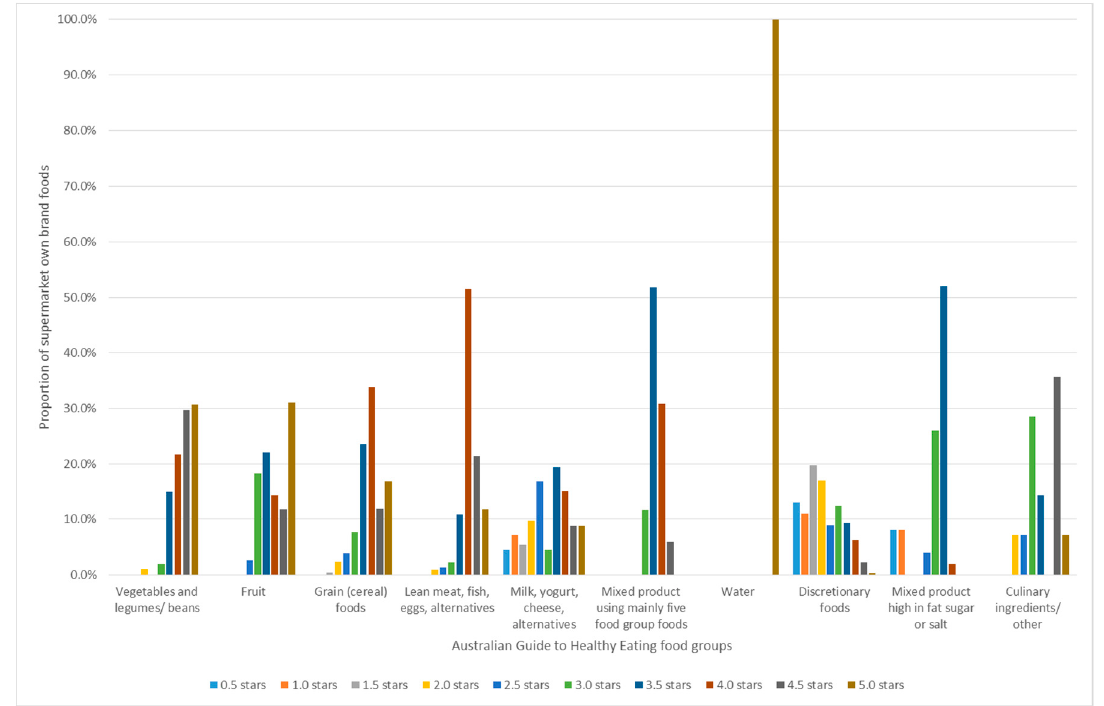
Figure 2. Frequency of Health Star Rating scores for supermarket own brand foods classified using the principles of the Australian Guide to Healthy Eating.